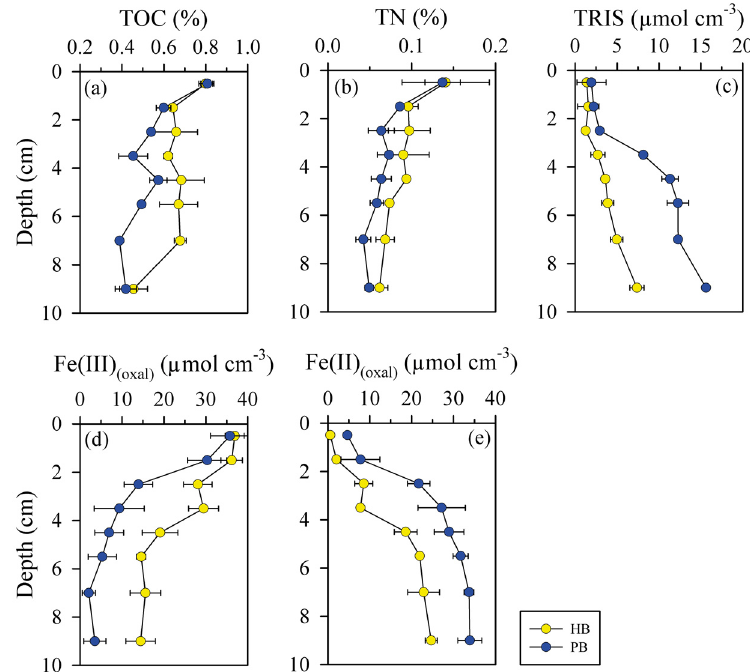
Fig. 3. Vertical profiles of total organic carbon (TOC), total nitrogen (TN), total reduced inorganic sulfur (TRIS), solid-phase Fe(II), and Fe(III) in the sediment. Horizontal bars indicate SE. HB: highly bioturbated; PB: poorly